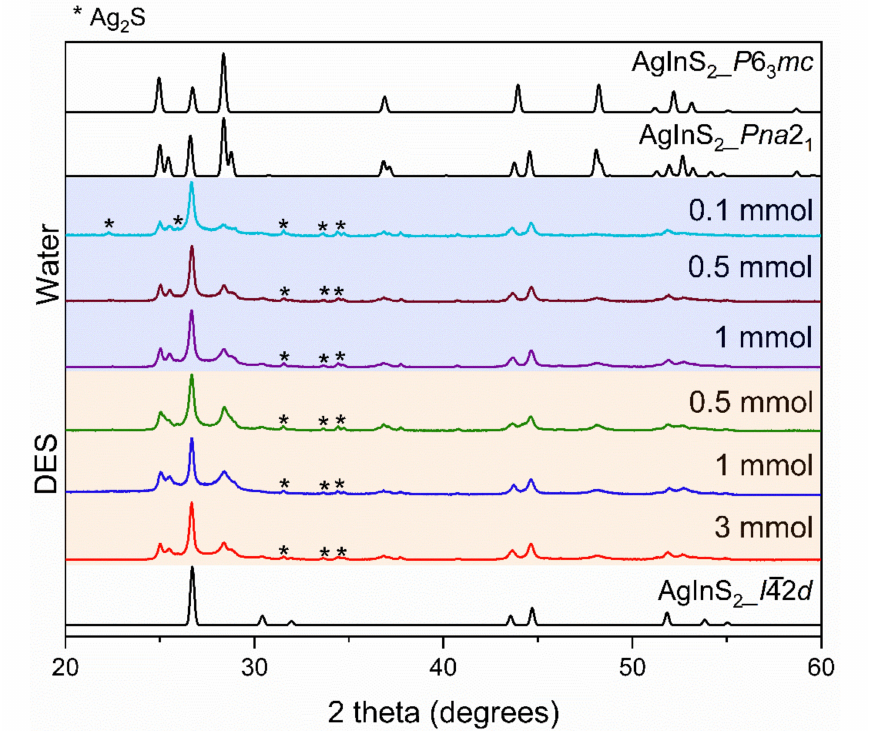
Figure 2. PXRD patterns of the 1-step synthesis of water (blue shaded region) and DES-synthesized (orange shaded region) AgInS 2 with varying concentrations of metal precursors. Diffraction peaks for Ag 2 S impurity are denoted with an asterisk (*). The theoretical PXRD patterns include ICSD 51617, representing the I 42 d ; ICSD 76276, representing the P 6 3 mc; and ICSD 605408, representing the Pna 2 1